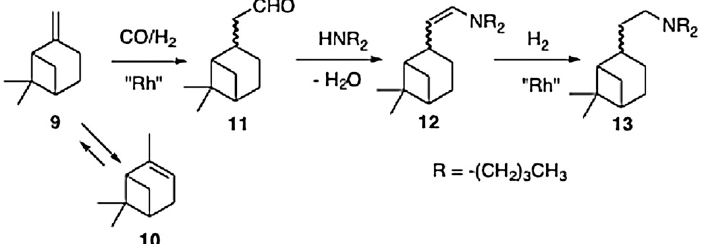
Figure 12. Hydroaminomethylation of β -pinene ( 9 ). Reprinted from [74] with permission from Elsevier.